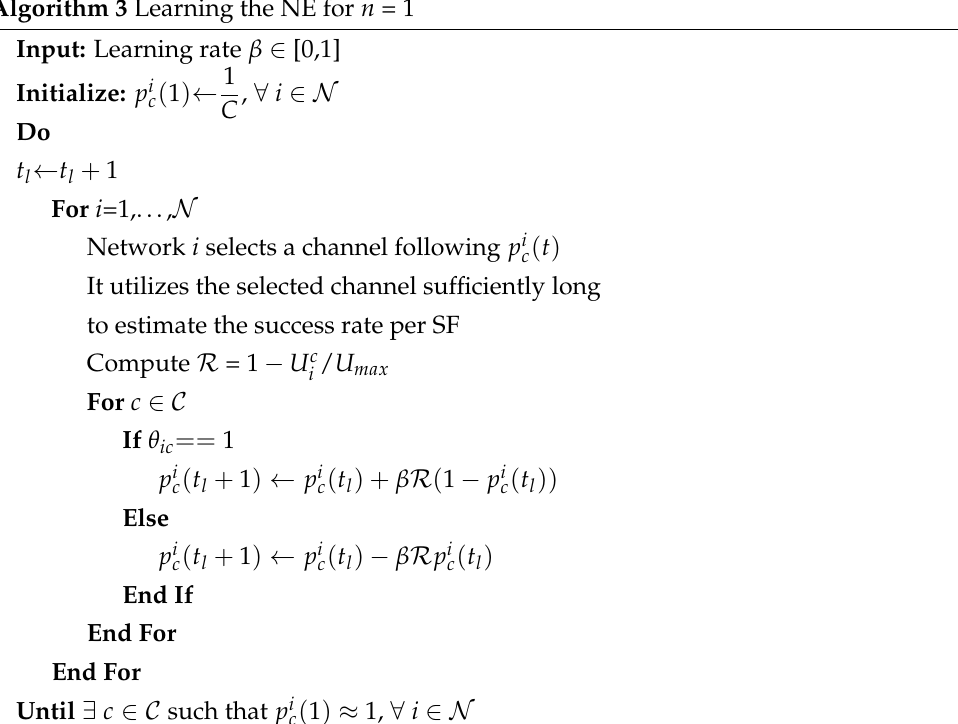
Algorithm 3 Learning the NE for n =